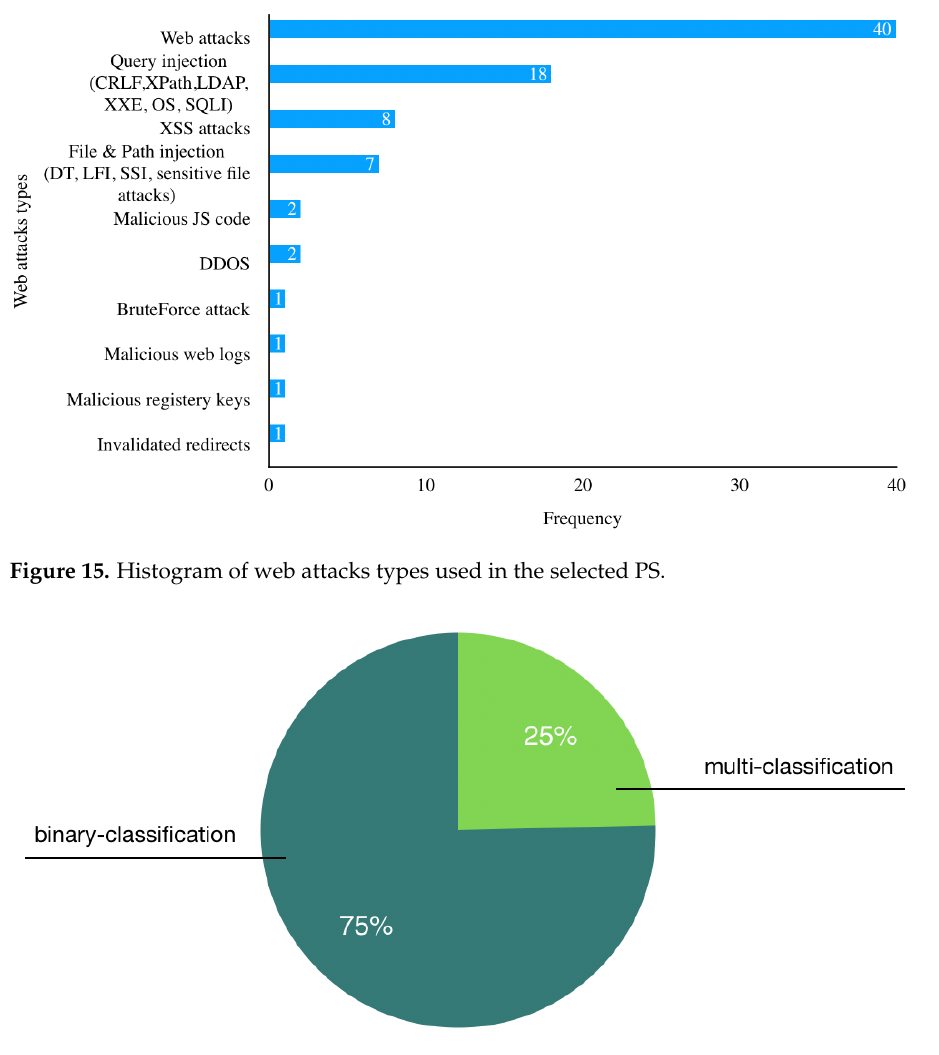
Figure 16. Percentage of studies proposing binary or multi-classification